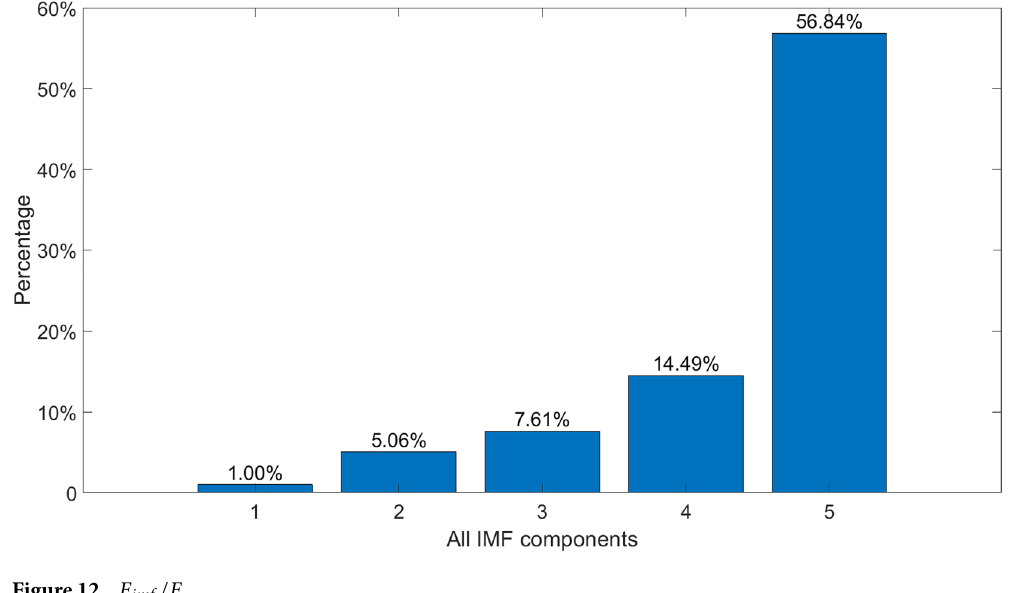
Figure 12. E imf / E .